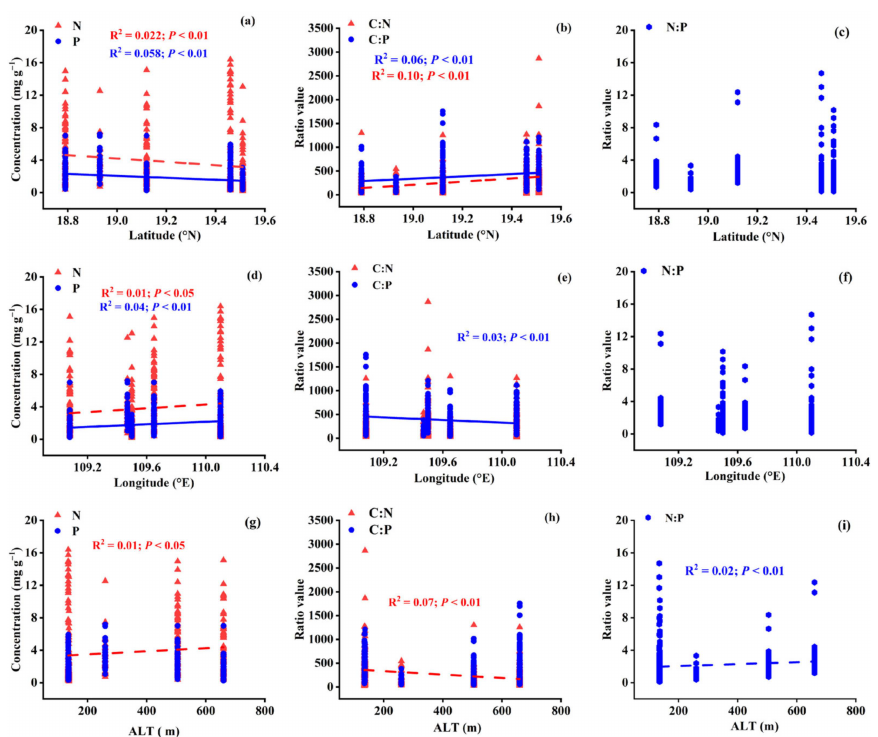
Figure 3. Correlation between leaf stoichiometry and geographical factors. Both the red dotted and blue solid lines represent significant correlations between leaf stoichiometry and geographical factors ( p < 0.05, p < 0.01). No line indicates the absence of a significant correlation between leaf stoichiometry and geographical factors. ALT: altitude.